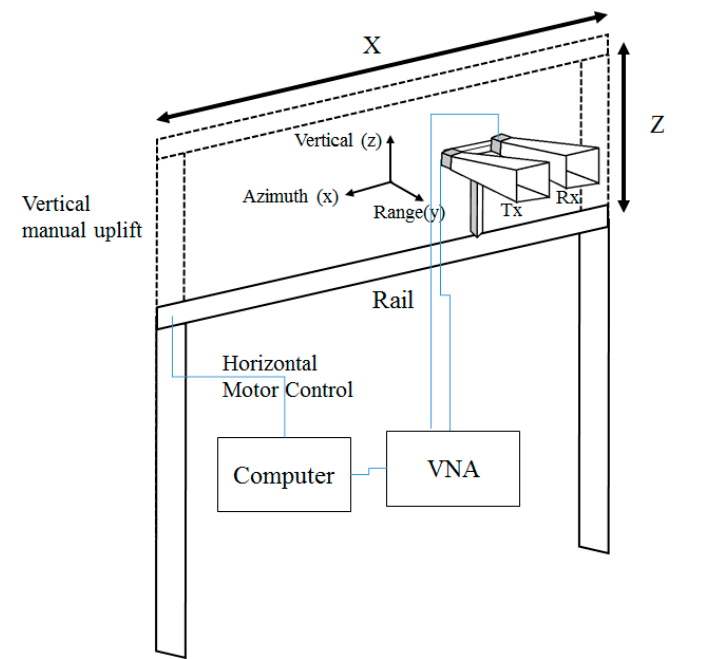
Figure 1. Pictures and a schematic diagram of GB-TomoSAR system.